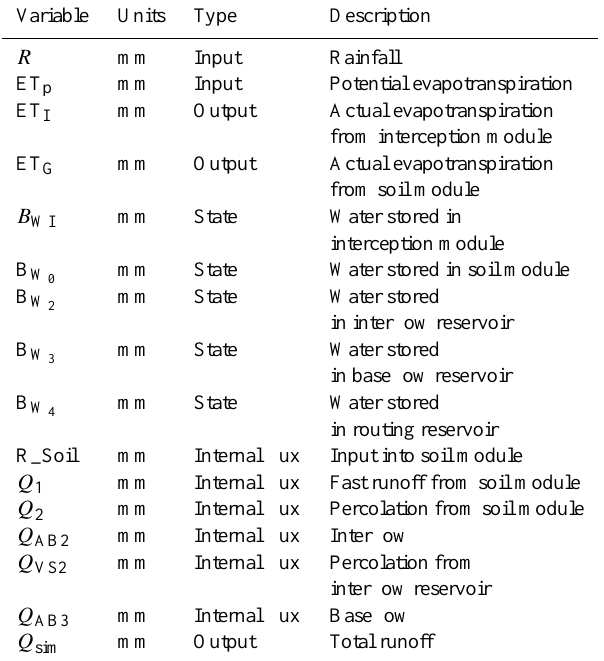
Table 3. Model fluxes and system states S i . Fluxes represent sums over the time